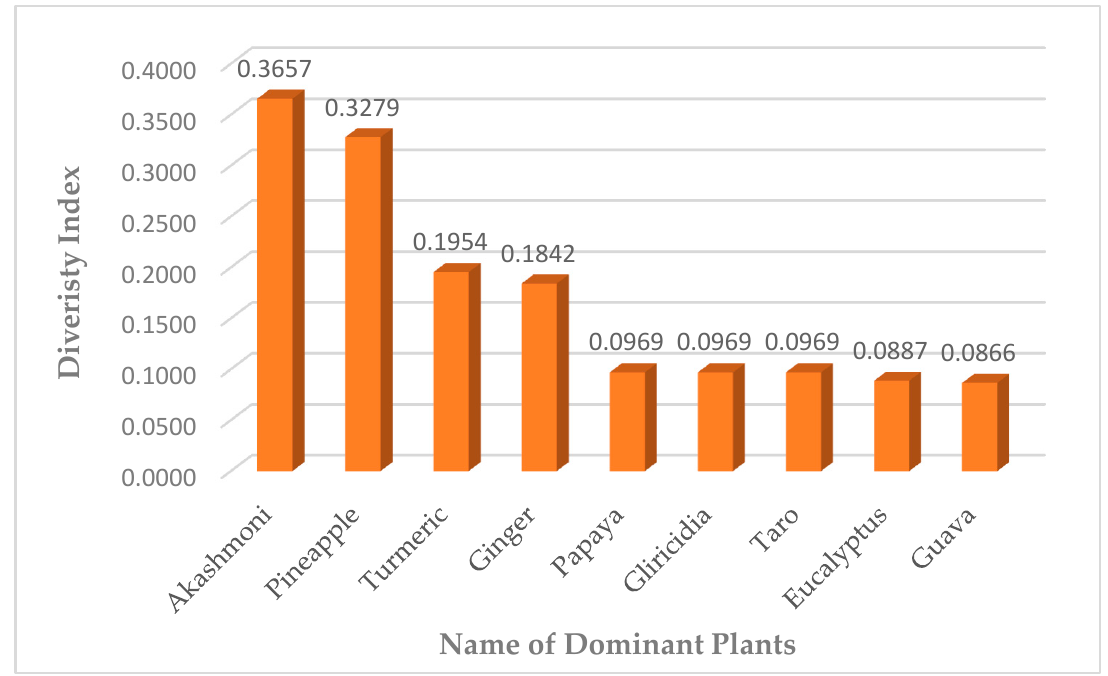
Figure 5. Diversity Index of the dominant plant species of Madhupur Area.